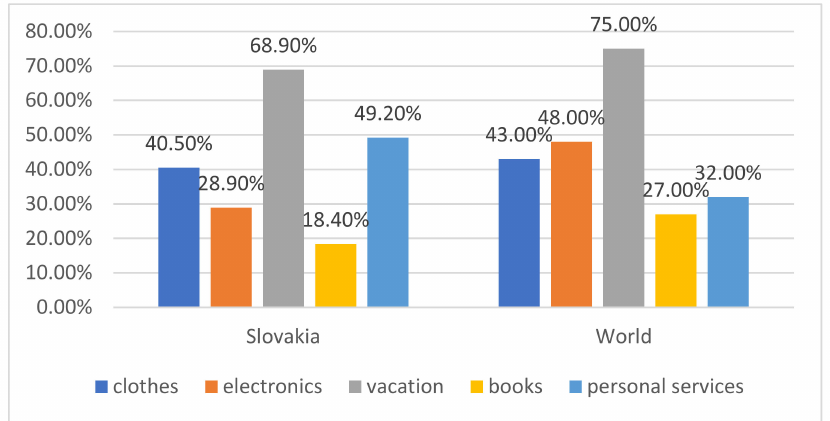
Figure 4. Illustration of decreased purchases by product categories. Source: according to